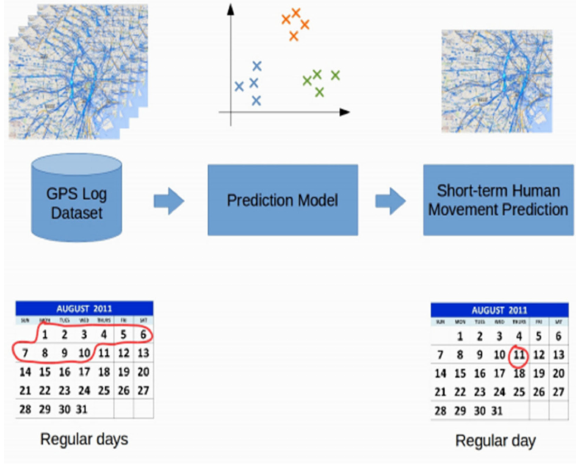
Figure 5. Prediction of regular crowd